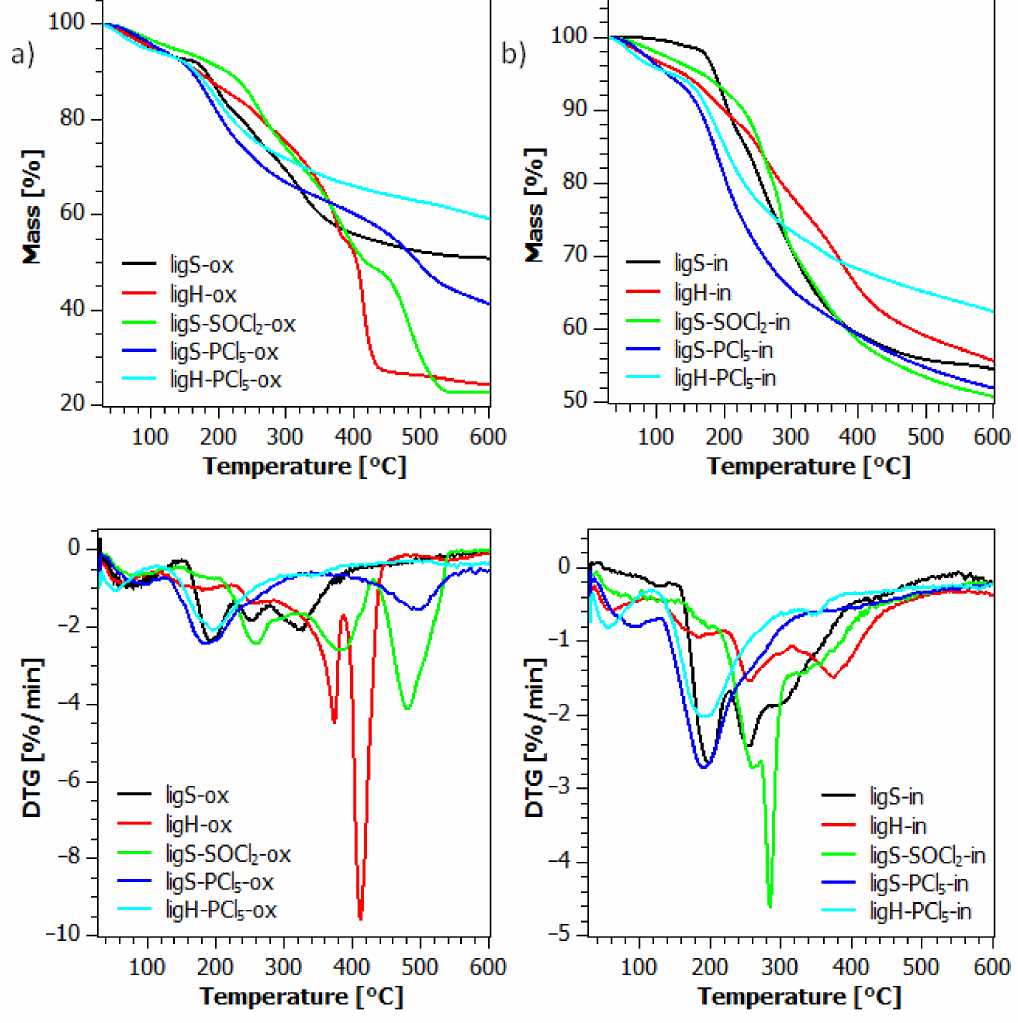
Figure 7. TG and DTG curves of the materials after the first step of modification during thermo- oxidative ( a ) and pyrolytic ( b )